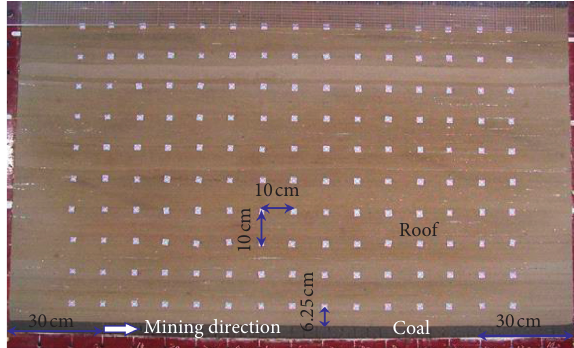
Figure 5: Two-dimensional similar model and the measuring